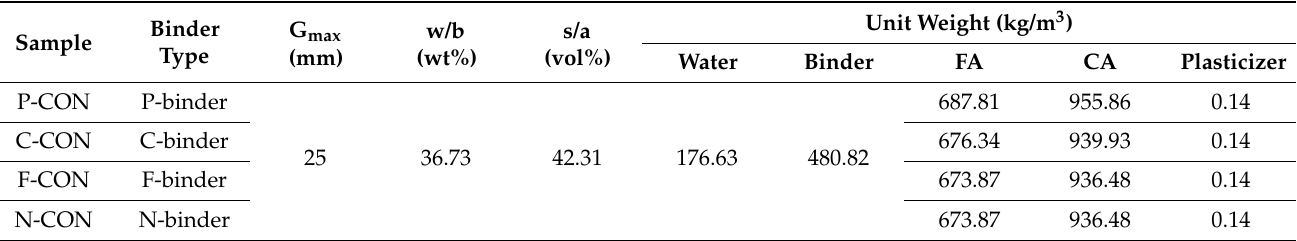
Table 3. Mixture proportions of concrete